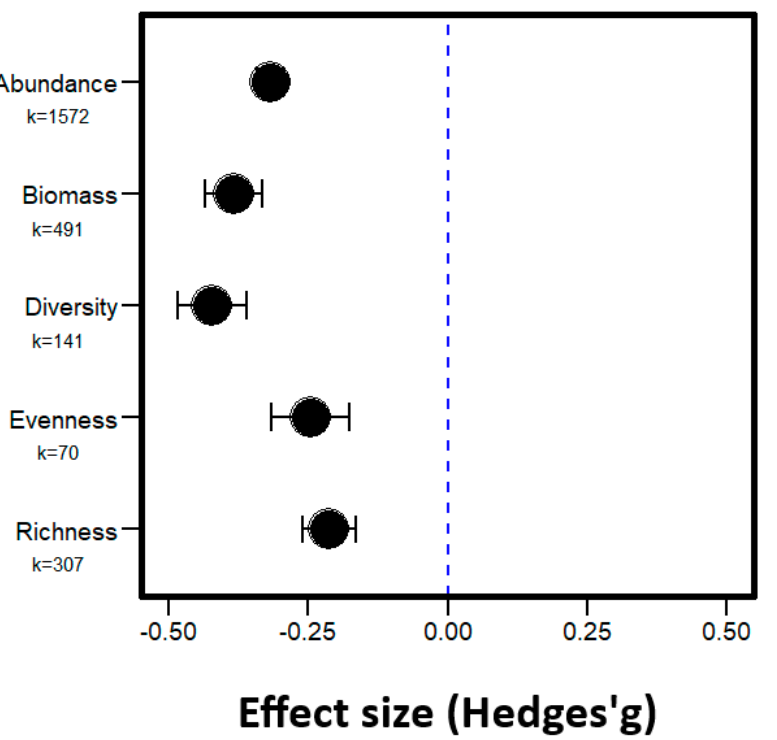
Figure 4. Overall effect of fire on abundance, biomass, diversity, evenness, and richness of all faunal groups. The x-axis shows overall effect size (Hedges’ g). k is the number of observations included in each analysis. Circles denote the Hedges’ g value and lines denote the 95% confidence intervals (CI) for each Hedges’ g value. Black circles represent significant effects whilst grey circles show no significant effects the Hedges’ g value.